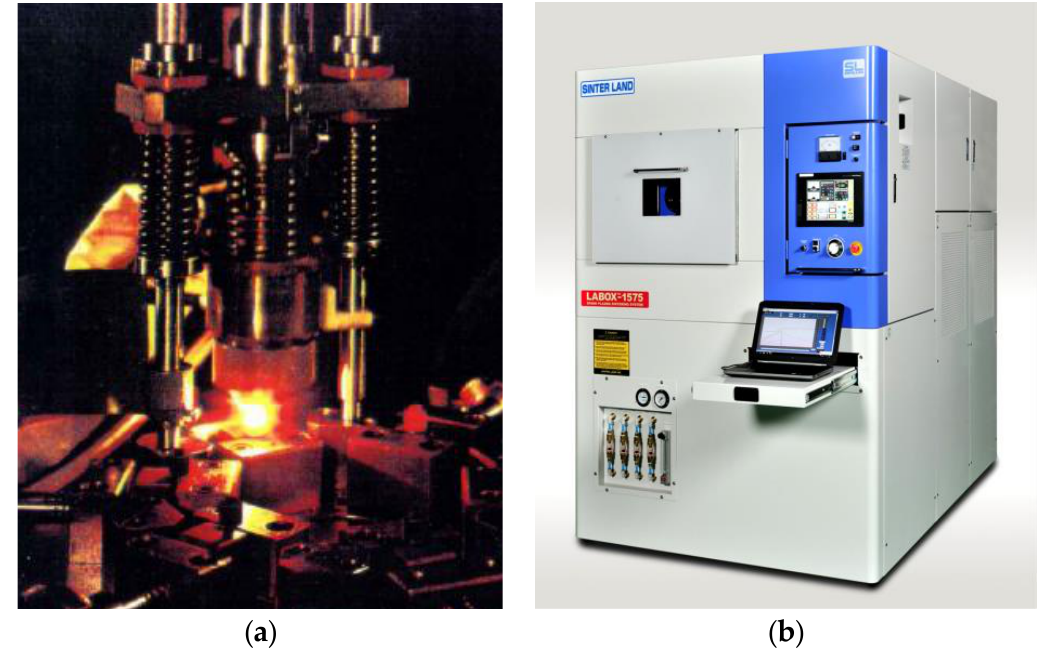
Figure 1. ( a ) The 1st generation SPS (open-air system) and ( b ) 5th generation SPS (vacuum system).